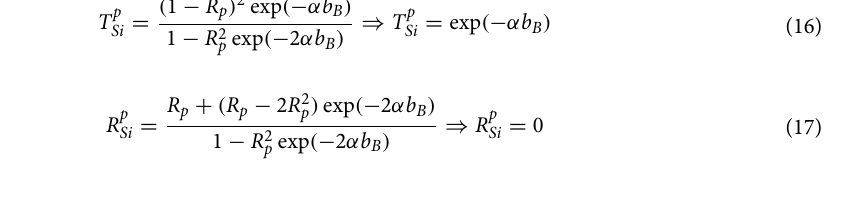
p T Si represents the total transmittance of p-polarized light through the silicon wafer ( T at the Brewster incidence angle). R Brewster incidence angle).